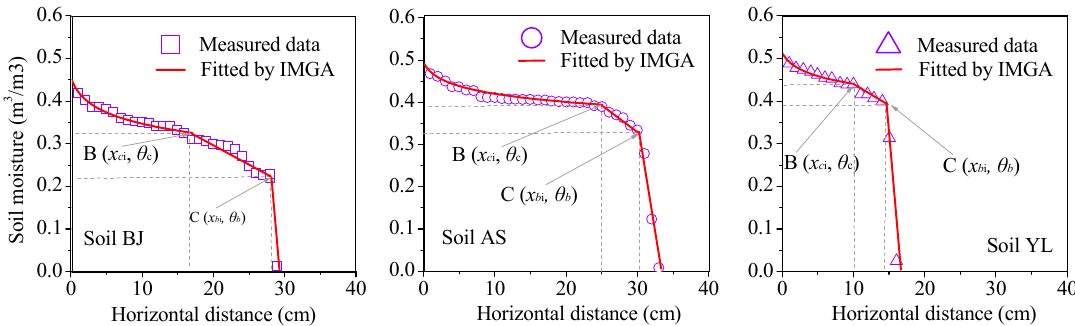
Figure 11. Soil moisture profiles measured by Mao et al. [35] and the fit results of the IMGA model. BJ, AS and YL represent soil samples collected in Beijing, Ansai, and Yangling (China), respectively.